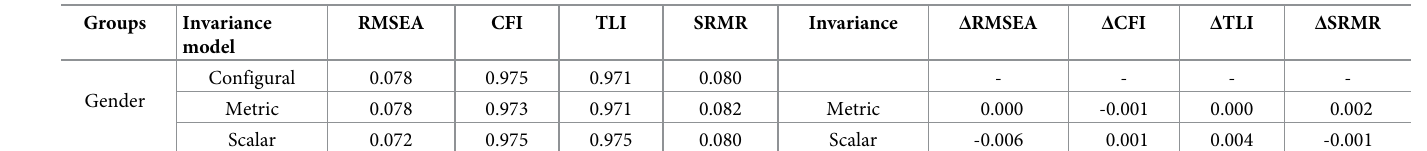
Table 2. Results of invariance analyses across gender (males, females).